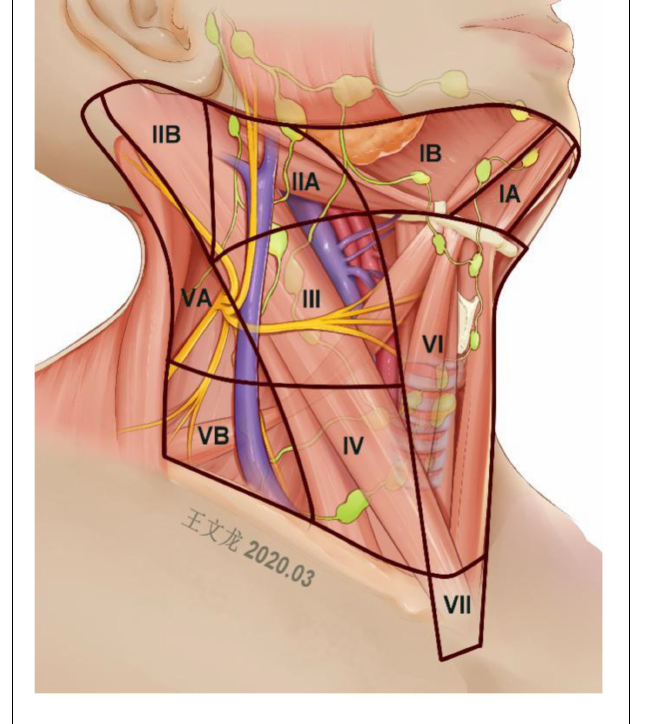
TABLE 1 | Clinicopathological characteristics of PTMC patients ( n =